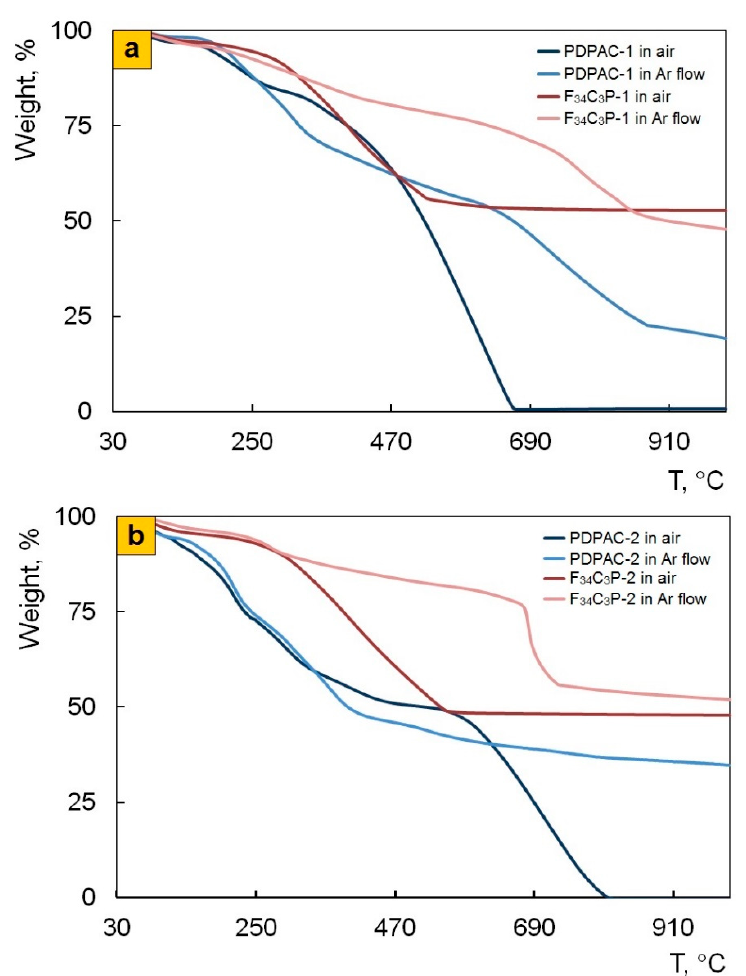
Figure 10. TGA thermograms of PDPAC and Fe 3 O 4 / SWCNT / PDPAC, prepared in alkaline ( a ) and acidic media ( b ), at heating up to 1000° С in the argon flow and in air. Table 4. Thermal properties of materials.